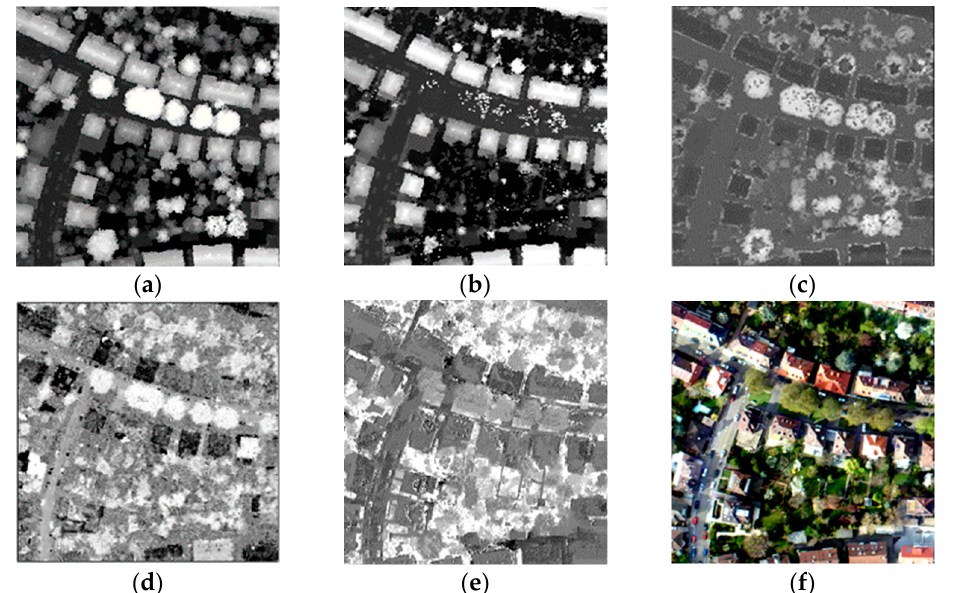
Figure 8. Test set 1 used in classification process: ( a ) FE; ( b ) LE; ( c ) HD; ( d ) IN; ( e ) NDVI; ( f ) RGB.